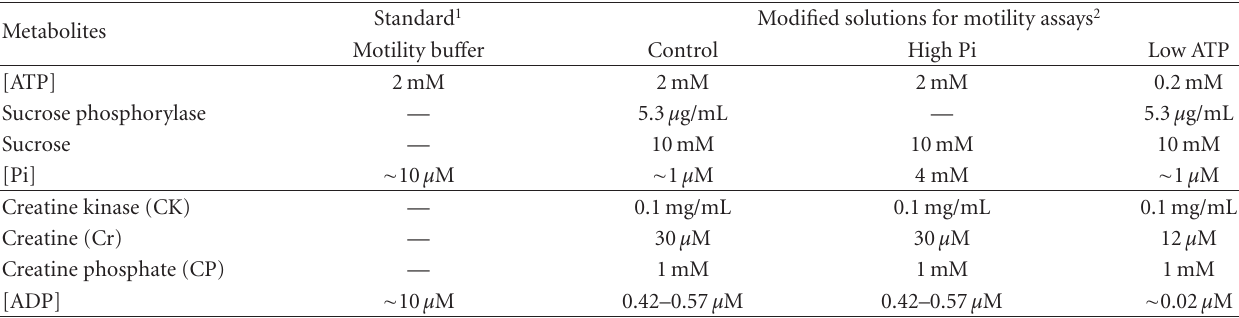
Table 1: Metabolite concentrations in standard and modified motility bu ff